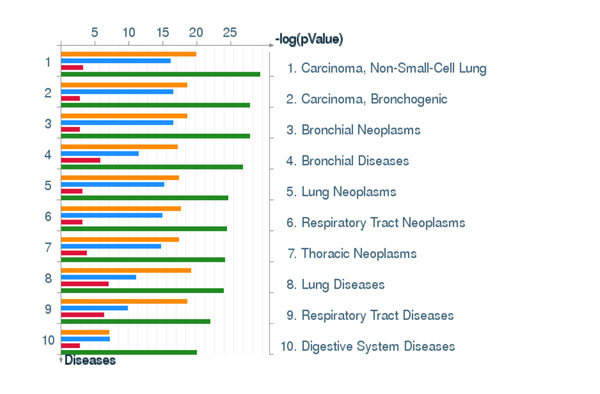
GeneGo disease association analysis. Sorting of the GO term enrichment is done by p-values. The p-value is estimated by GeneGo MetaCore ‘Statistically significant Diseases’ method. Yellow: cluster 1, blue: cluster 2, read: cluster 3, and green: cluster 4. Selected genes of the GO clusters are described in Table 2. Cluster 1 (top) includes genes of Inflammatory response, Regulation of cytoskeleton organization, Positive regulation of response to stimulus, Wound healing, Response to mechanical stimulus, Negative regulation of cell proliferation, Regulation of locomotion, Complement activation, Positive regulation of immune response, Hormonal immune response. These genes are suppressed in AC vs AT. Cluster 2 includes the genes of M phase of mitotic cell cycle, Negative regulation of intracellular transport, Microtubule-based process, Response to DNA damage stimulus, Spindle organization, Cellular protein localization DNA repair, Glycosylation. These genes are overexpressed in AC vs AT. Cluster 3 includes the genes of Enzyme linked receptor protein signalling pathway, Metal ion homeostasis, Protein amino acid phosphorylation, Transmembrane receptor protein tyrosine kinase signalling pathway, Negative regulation of cell proliferation. These genes are suppressed in AC vs AT. Cluster 4 includes the genes of Collagen fibril organization, Collagen metabolic process, Glycolysis, Carbohydrate catabolic process, Extracellular structure organization, Negative regulation of cell adhesion, Generation of precursor metabolites and energy, Negative regulation of protein ubiquitination. Cluster 4 includes the genes up-regulated in AC vs AT (Figure 7).